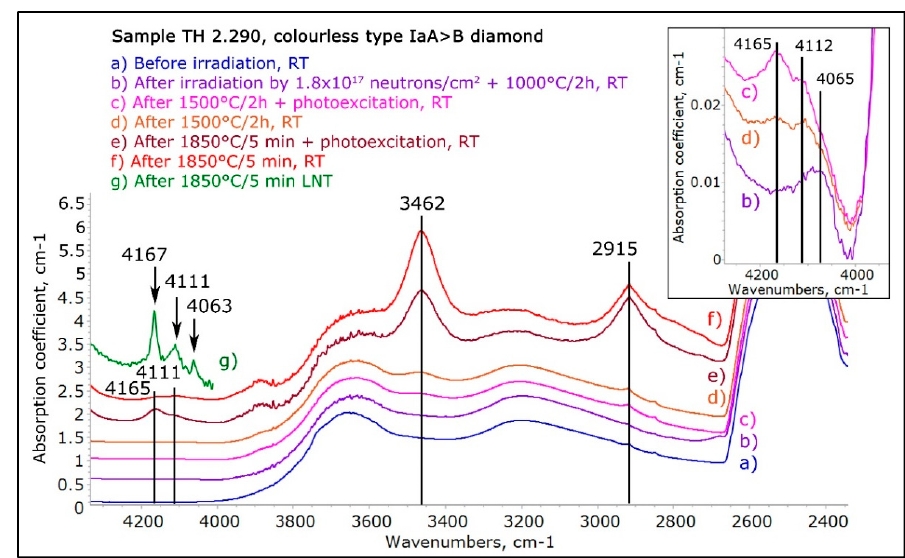
Figure 11. The IR/NIR spectra showing the evolution of an originally colorless type IaA>B “cape series” diamond before neutron treatment (trace a), after heavy neutron irradiation and annealing for 2h at 1000 °C (trace b), after 2h at 1500 °C (trace d), after 2h at 1500 °C with photoexcitation (trace c), after 1850 °C for 5 min (trace f) after 1850 °C for 5 min with photoexcitation (trace e), and, finally, the low temperature NIR spectrum after 1850 °C for 5 min (trace g). At 1000 °C, a weak 4065 cm − 1 absorption was formed, After 1500 °C, weak 4165 and 4112 cm − 1 absorptions were apparent plus the absorption at 3462 cm − 1 appeared and a hint of the 2915 cm − 1 absorption was detectable; photoexcitation caused the 3462 cm − 1 band to decrease while the 4165 cm − 1 peak increased. After 1850 °C, the spectral features detected after annealing at 1500 °C became distinctly stronger, but their behavior remained identical. The spectrum recorded with the diamond at 77 K shown in trace g demonstrates the distinct increase, sharpening and peak shifting of the three peaks at low temperature. The peak shapes, positions, photoexcitation, and low temperature behavior are all identical to what has been described for the ACs, and hence it appears highly likely that what was created are indeed treatment-induced ACs. The spectra were shifted vertically for clarity.